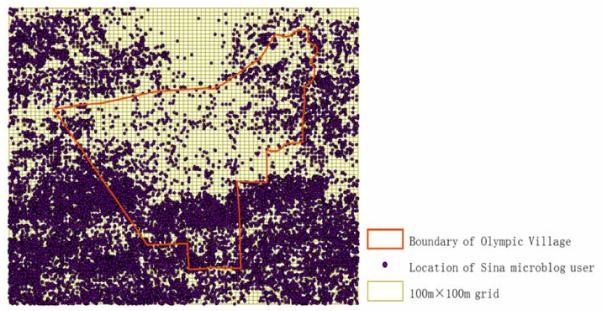
Figure 2. The locations of Sina Microblog users in June 2014 in and near the Olympic Village, overlaid on 100 m × 100 m